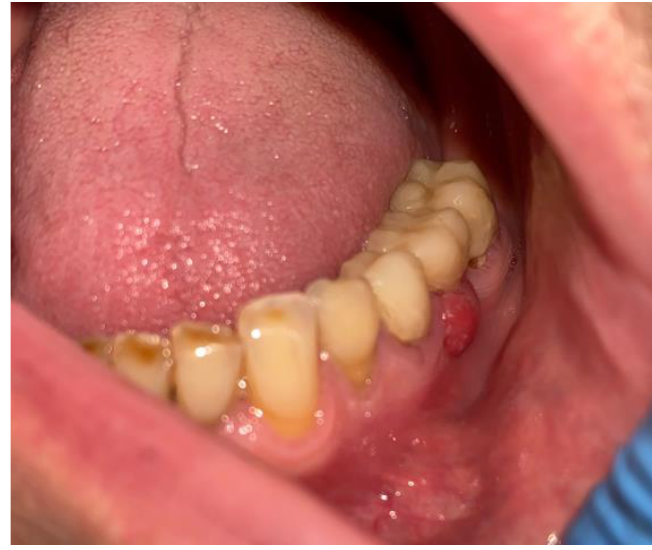
Figure 5. Intraoral photograph with granulation tissues arising from under the dental bridge.